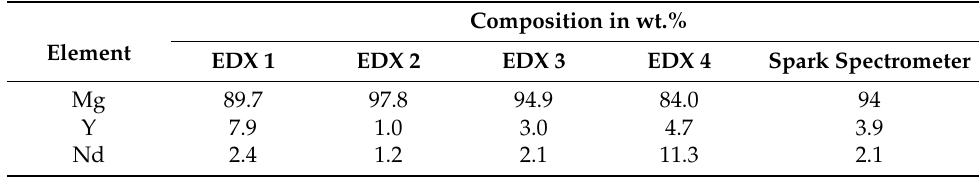
Figure 7. Element mapping of Mg, Nd and Y of the specimen in section in 6b. Unlike the grain structures of the parts generated with PBF-LB, the phases of these parts were arranged differently. In the samples for the bending tests (Figure 8a,b), most of the precipitates were inhomogeneously distributed. Only a few layers consisted of evenly distributed precipitates. The higher-magnification image (Figure 8b) shows that the precipitates were agglomerated in some areas, but they still formed mostly fine struc- tures in those agglomerations. Only in some cases did clusters of precipitates occur. In contrast, large parts of the compression test samples (Figure 8c,d) contained small and homogeneously distributed precipitates. However, there were still areas with agglomer- ated precipitates similar to the cuboid samples, as shown in Figure 8e,f. Although, locally, a homogeneous structure could be realized, the process was still not stable enough to pro- duce a large volume with a homogeneous structure and a density above 99%. As with the as-cast samples, the composition of the different phases was also analyzed in the PBF-LB- generated parts. Besides the spots in Figure 9, a large-area EDX measurement (EDX 5) of Figure 8a was conducted. The compositions of the different phases, independent of the samples, were similar to each other, which is why only a representative EDX analysis of one PBF-LB-generated part is shown in Table 4. The Nd and Y content is rather high in the large-area EDX measurement. To determine the impact of the process on the compo- sition, an additional EDX measurement of the initial powder was conducted on several